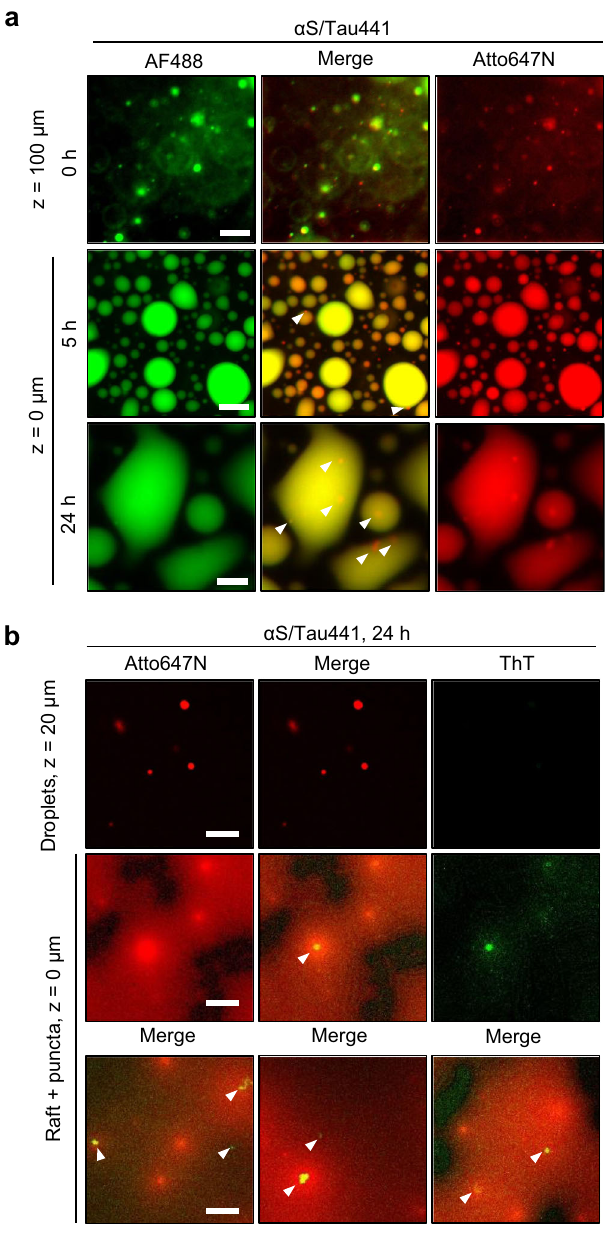
Fig. 5 | Liquid-to-solid phasetransitionandamyloid aggregationof α S/Tau441 coacervates.a WFmicroscopyimagesof25 μ M α Sinthepresenceof25 μ MTau441 (1 μ M AF488-labeled α S and Atto647N-labeled Tau441) in LLPS buffer at different incubationtimesandfocalheights( z ,distancefromthebottomofthenon-binding plate well).Sixexperimentswererepeatedindependentlywithsimilarresults. b CF microscopy images of 25 μ M α S in the presence of 25 μ M Tau441 (1 μ M Atto647N- labeled Tau441) and 12.5 μ M thio fl avin-T (ThT). Suspended protein droplets and deposited protein rafts and puncta are shown in the top and middle rows, respectively. The bottom row shows images of rafts and puncta from 3 indepen- dentreplicateexperiments.WhitearrowheadsindicateThT-positivepunctainboth panels. Scale bar is 20 μ m for all